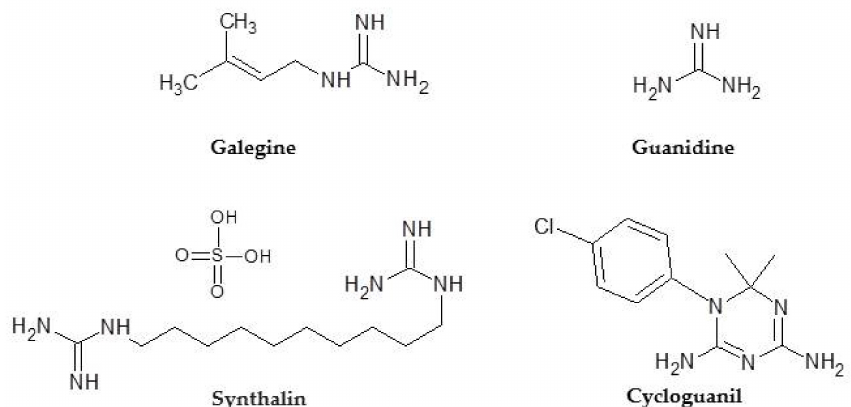
Figure 1. Compounds from which the chemical evolution of phenformin and buformide derives.